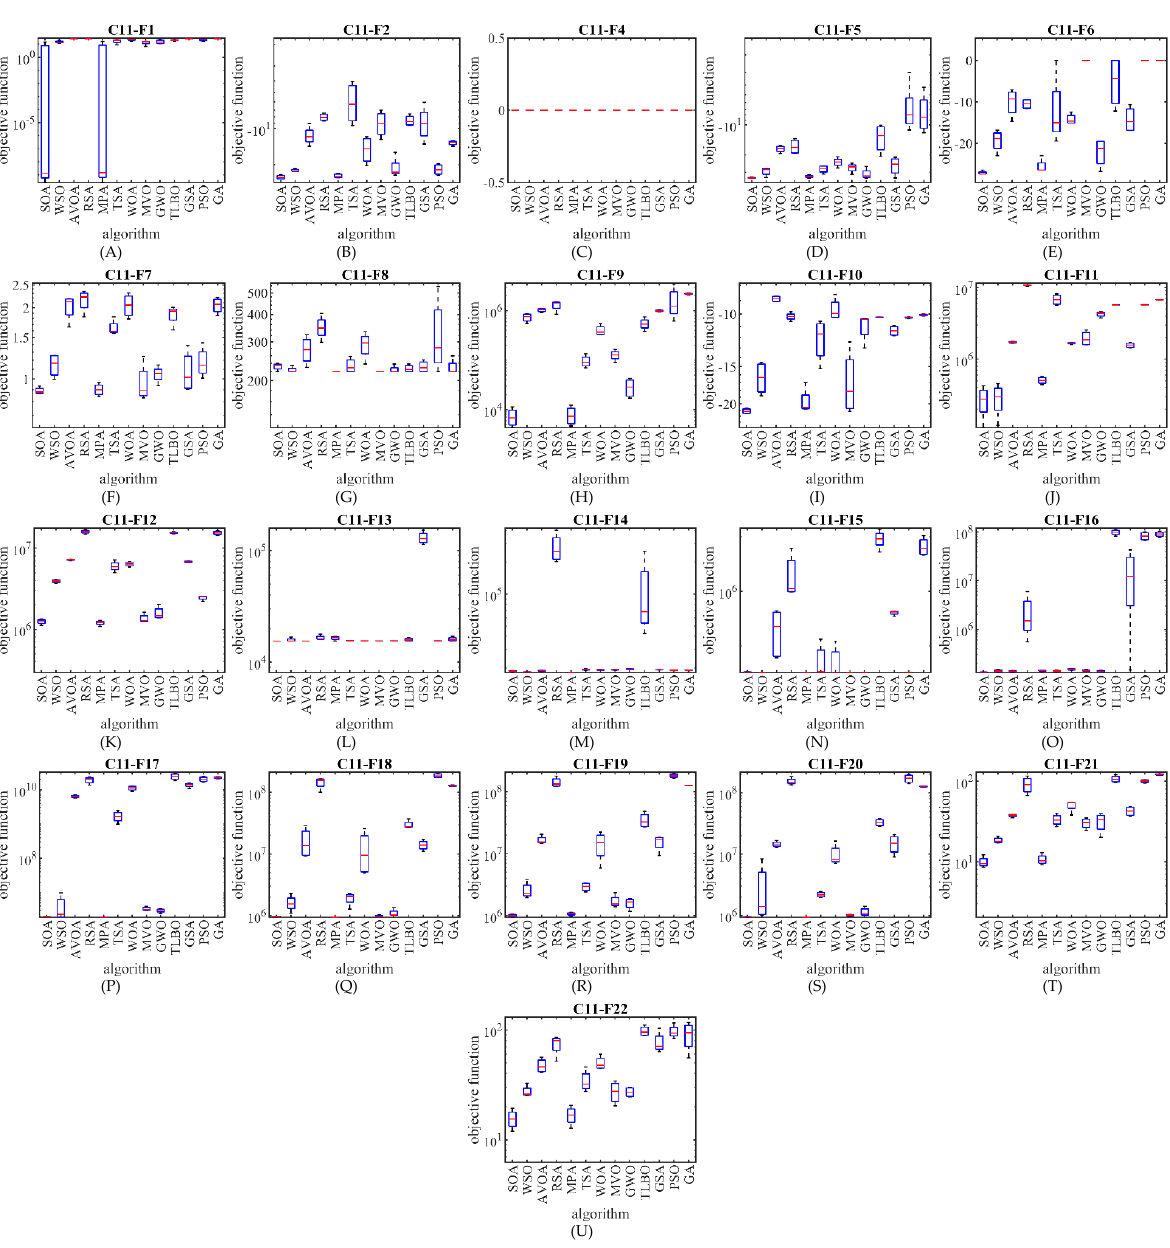
Figure 7. Boxplot diagram of SOA and competitor algorithms performances on the CEC 2011 test suite.